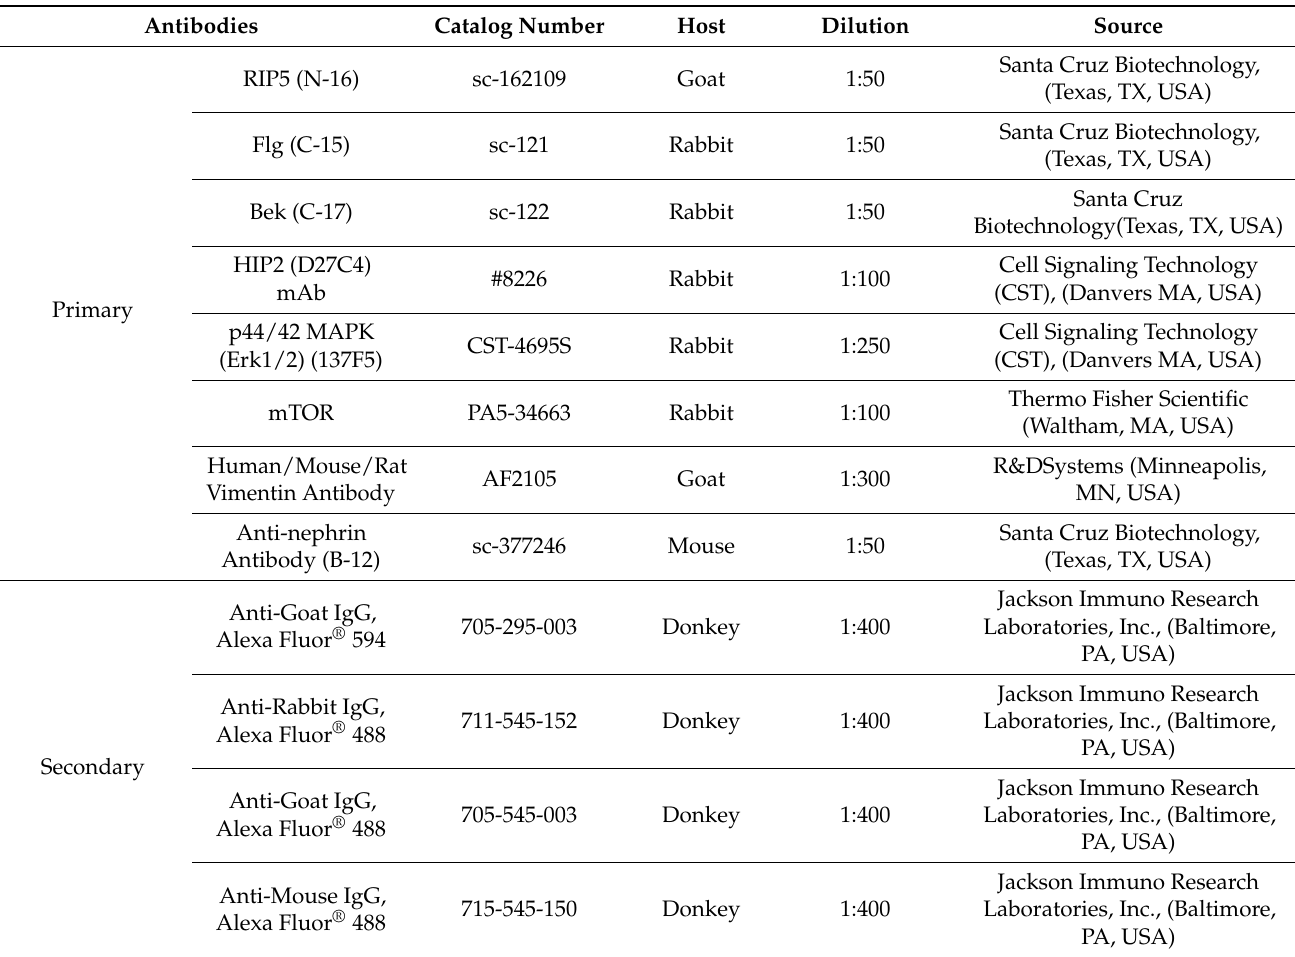
Table 3. Antibodies used for